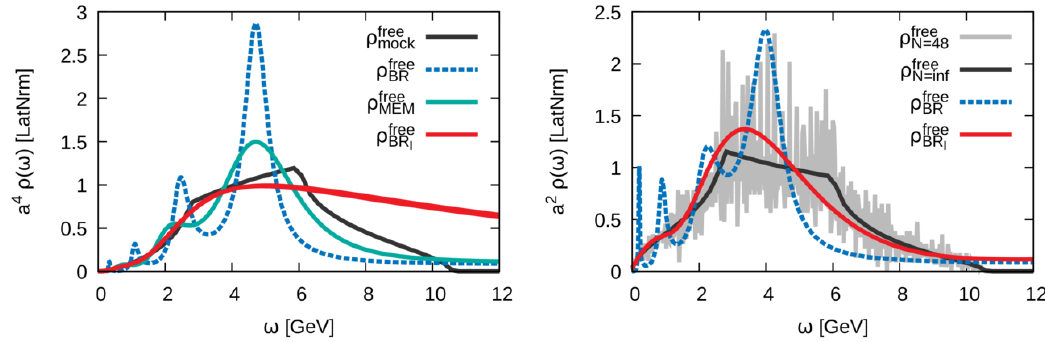
Figure 2 . (left) Representative examples of mock data reconstructions based on the in(cid:12)nite volume free P-wave spectral function (black solid) encoded in twelve correlator points along Euclidean time ((cid:1) D=D = 10 (cid:0) 3 ). Three di(cid:11)erent Bayesian methods are shown: the standard BR method (blue dashed), the MEM (green) and the modi(cid:12)ed BR method with (cid:20) = 1. In the phenomenologically relevant regime up to the (cid:12)rst kink, our new method is accurate and does not show any ringing. (right) Reconstruction of the S-wave free spectral function from actual N (cid:28) = 12 lattice data ( N conf = 400). The black solid line denotes the in(cid:12)nite volume spectral functions, while the light gray line show the spectrum actually encoded on the 48 3 (cid:2) 12 lattice when taking the same frequency resolution as in the Bayesian methods. Here we show the outcome of the standard BR method (blue dashed) and the new modi(cid:12)ed method with (cid:20) = 1 which again up to ! = 2GeV shows good accuracy and no